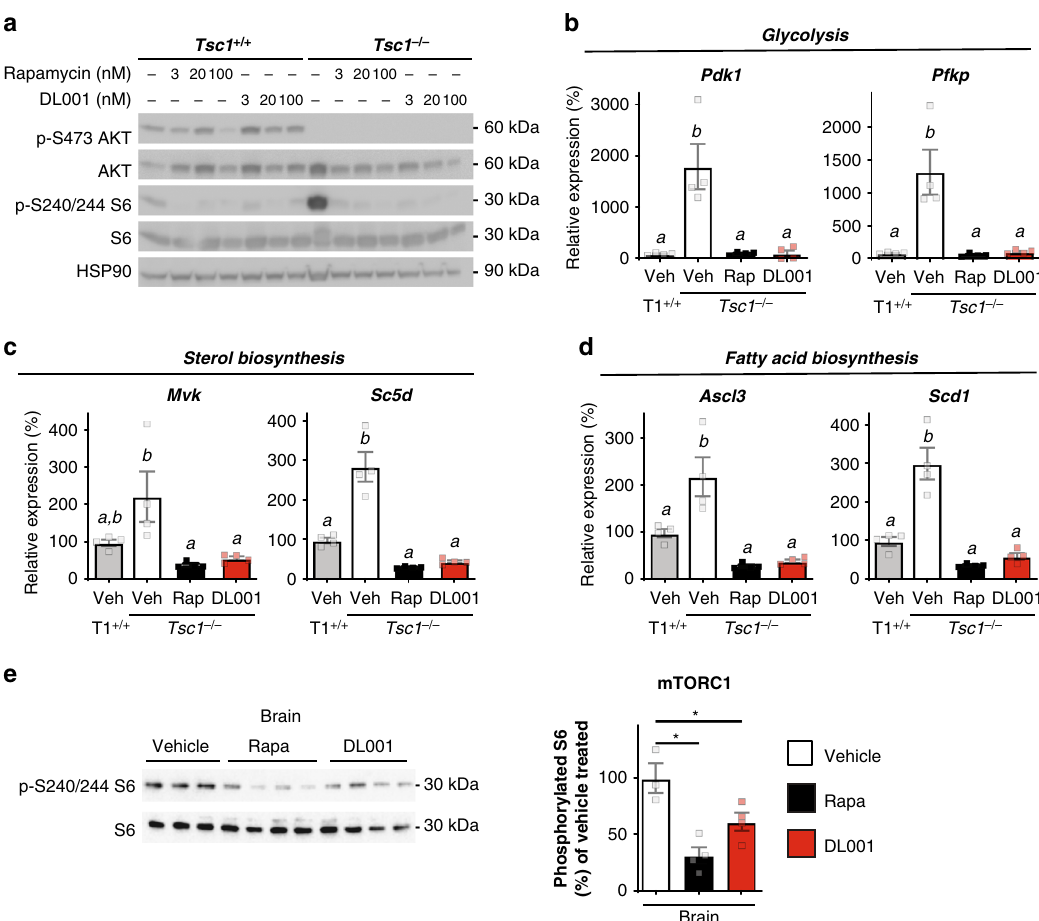
Fig. 5 DL001 corrects mTORC1-mediated signaling and metabolic defects of TSC1 − / − cells. a Immortalized mouse embryonic fi broblasts